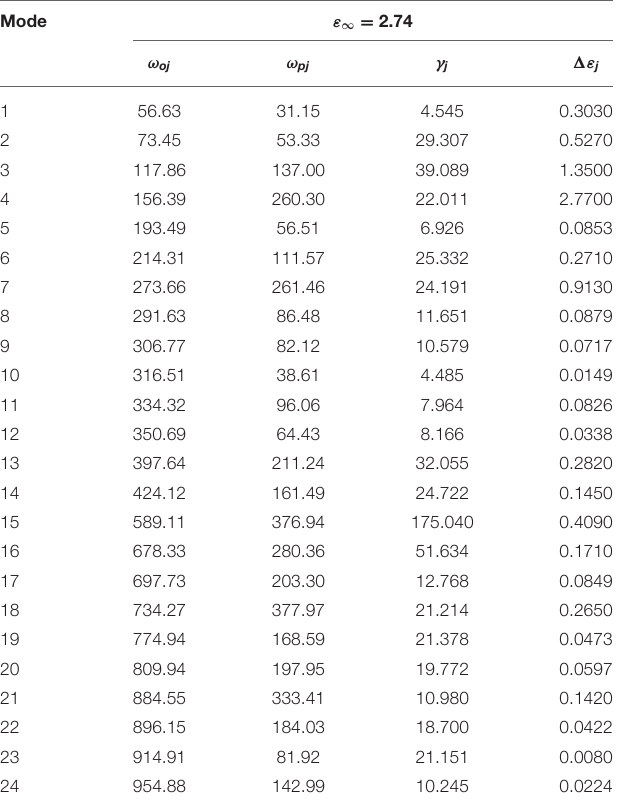
TABLE 3 | Phonon parameters obtained from the fitting of the infrared spectra of Ce